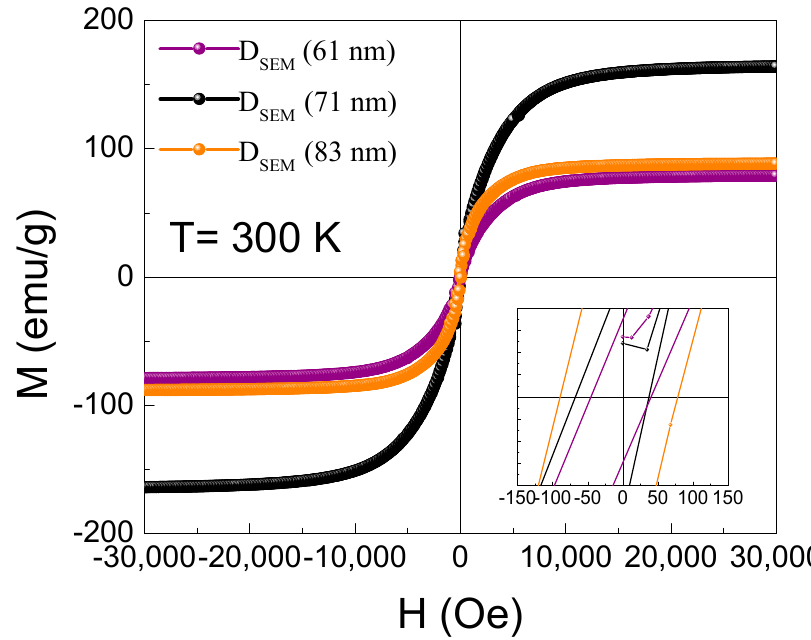
Figure 2. M-H curves at 300 K for Fe/Au core-shell nanoparticles. The results are consistent with the phase structural data obtained from XRD and TEM